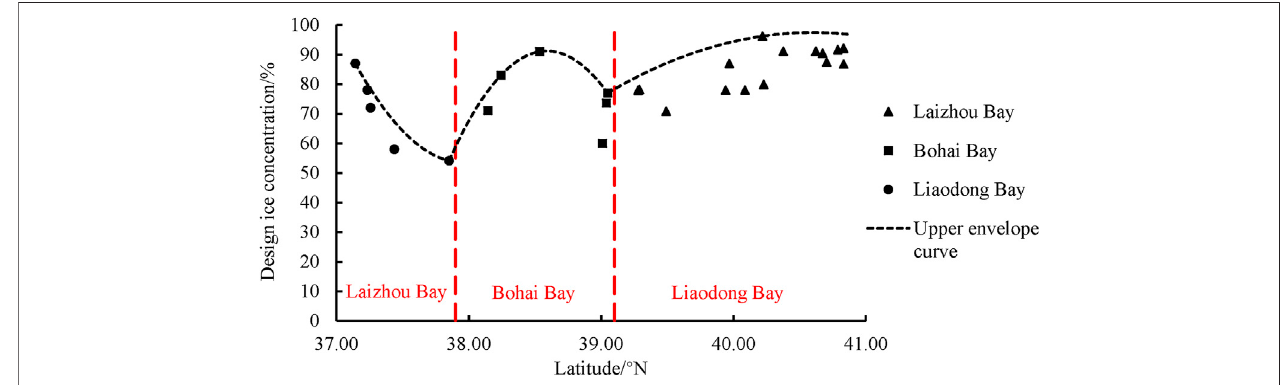
FIGURE 8 | Variation of design ice concentration with latitude in the Bohai Sea.